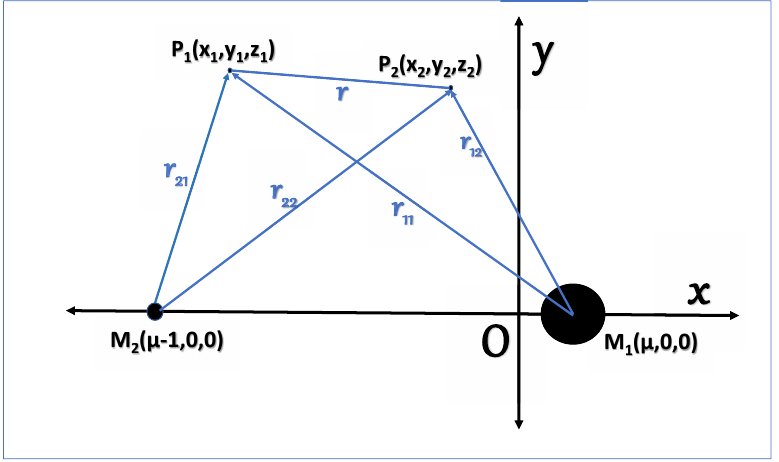
Figure 1. Restricted 2 + 2 body problem